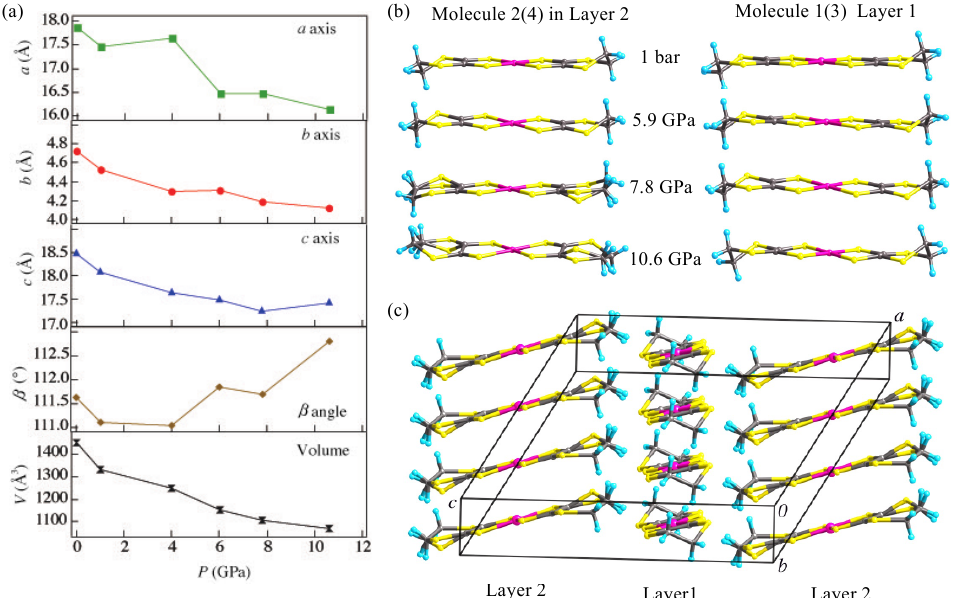
Figure 3. ( a ) Pressure dependence of cell parameters a , b , c , β and V . ( b ) Crystallographically independent [Pd(dddt) 2 ] molecules at different pressure in Layer 1 and Layer 2. ( c ) Crystal structure of [Pd(dddt) 2 ] at 7.8 GPa. Palladium, sulfur, carbon and hydrogen atoms are shown in pink, yellow, grey and cyan, respectively.